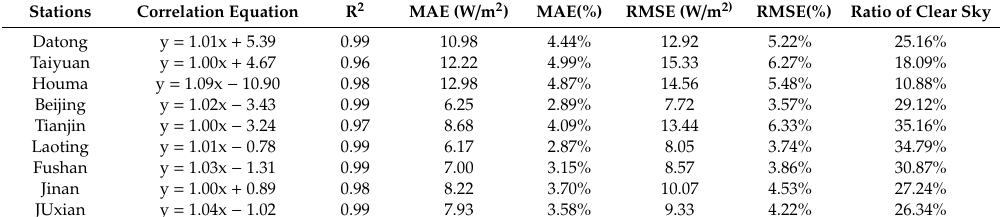
Table 1. The statistical analysis between monthly observed and simulated clear-sky SSR.